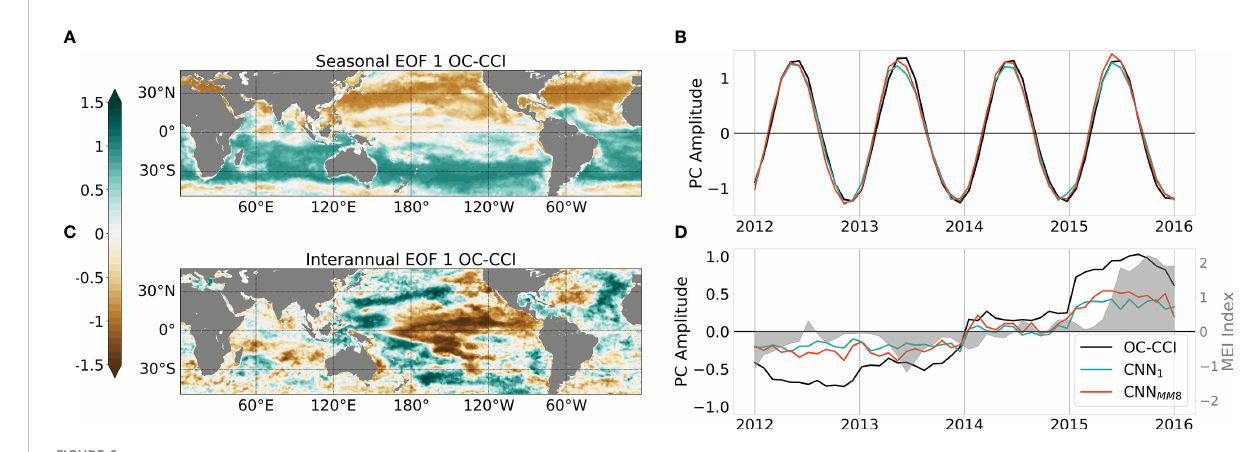
FIGURE 6 (A) Spatial pattern and (B) associated principal component (PC, as the black line) of the EOF fi rst mode calculated on seasonal ChlOC-CCI over [2012-2015]. ChlCNN1 and ChlCNN-MM8 PCs obtained from the projection on ChlOC-CCI EOF spatial pattern are reported as the green and orange lines, respectively. (C, D) same as (A, B) but for the interannual signal. In (D) , the MEI is reported as the grey shaded